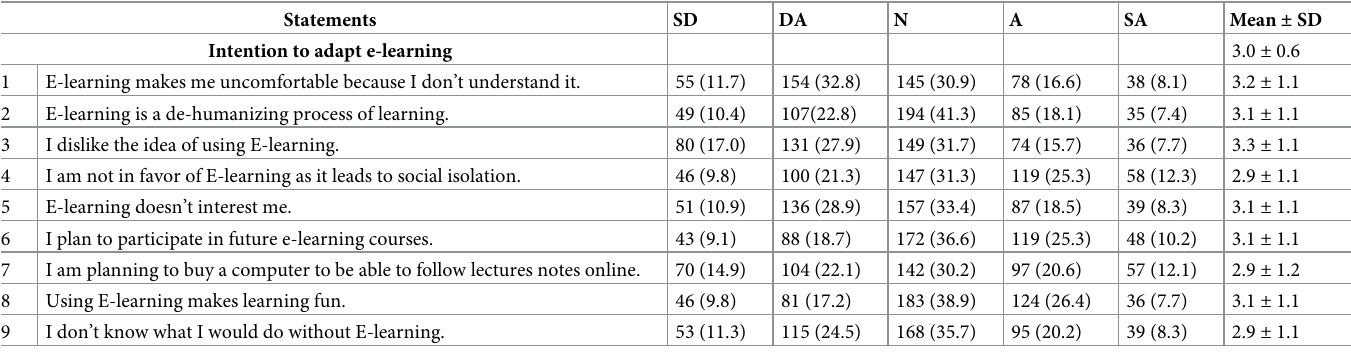
Table 4. Intention to adapt (n = 470).